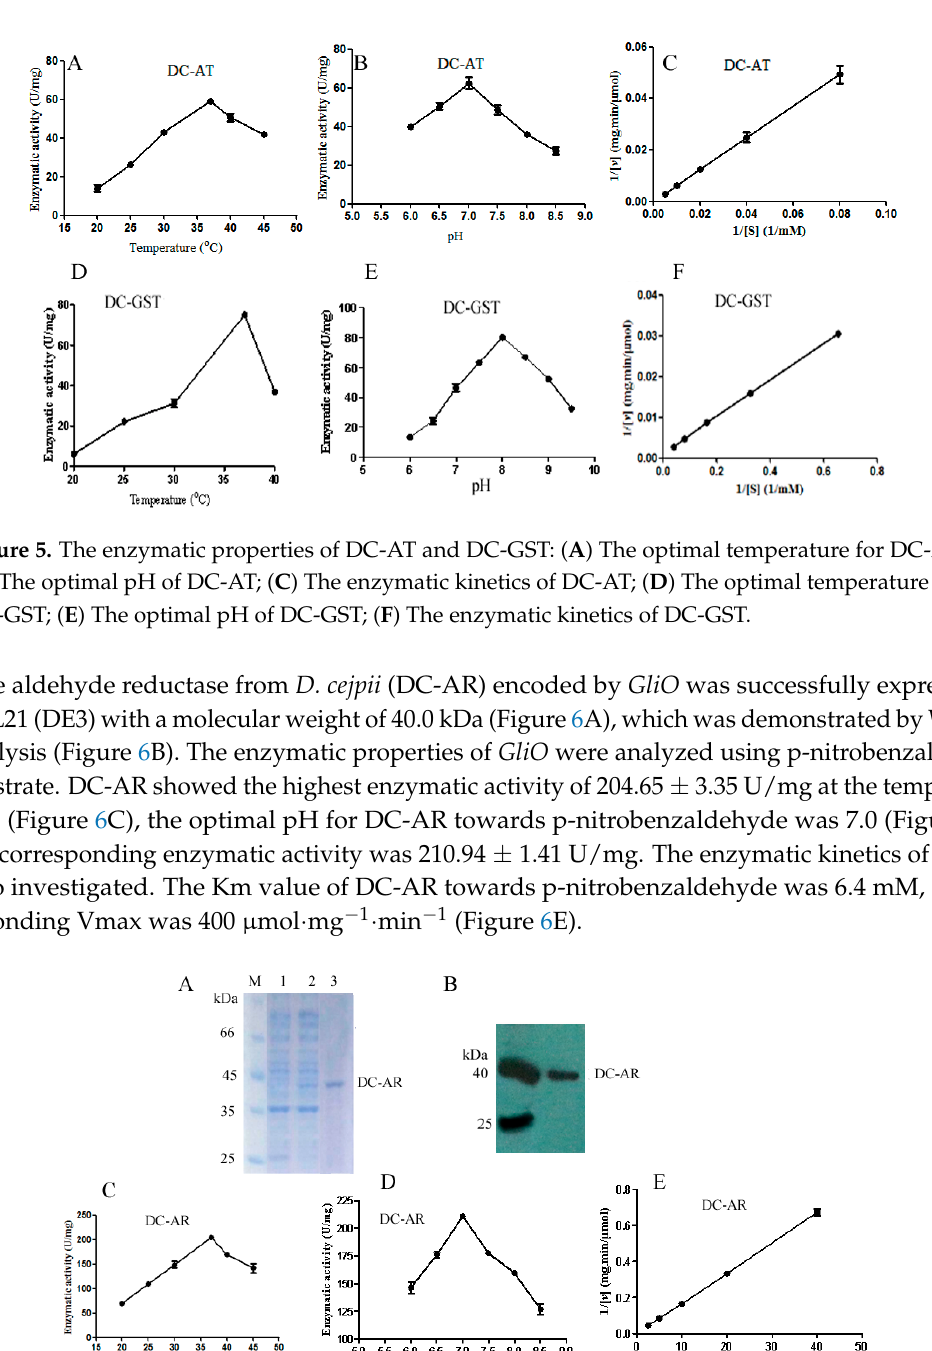
Figure 6. The identification of DC-AR from D. cejpii : ( A ) The purification of DC-AR: M, protein marker; 1. Uninduced sample of DC-AR; 2. Induced sample of DC-AR; 3. 100 mM imidazole eluate of DC-AR; ( B ) The Western blot analysis of DC-AR; ( C ) The optimal reaction temperature of DC-AR; ( D ) The optimal reaction pH of DC-AR; ( E ) The enzymatic kinetics of DC-AR.